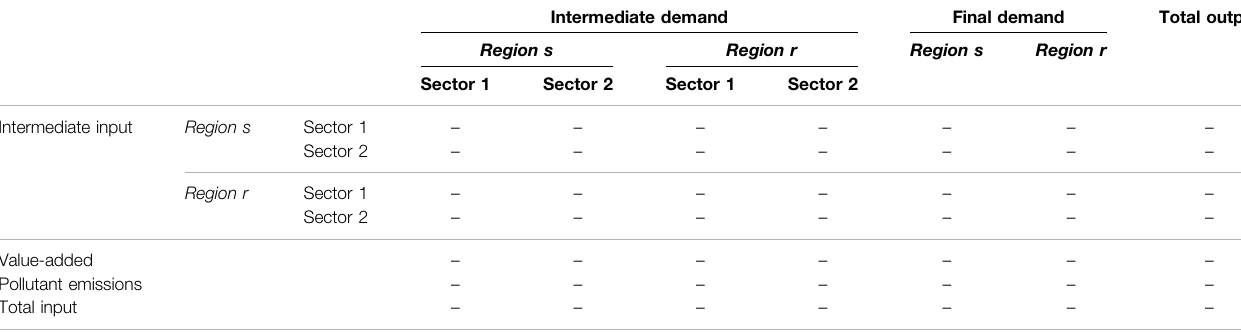
TABLE 1 | Illustration of inter-regional inputoutput table (two countries and two sectors).